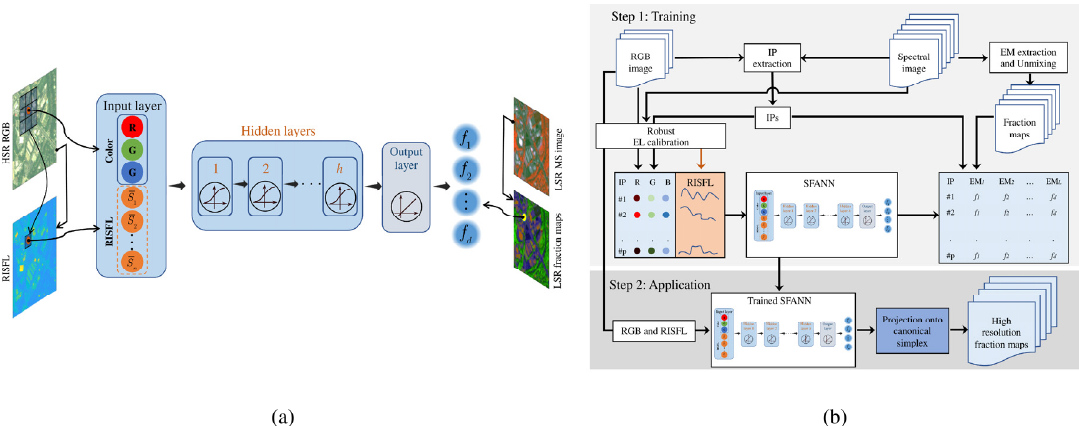
Figure 5. ( a ) Architecture of the spatial features-aided neural network (SFANN) designed for fraction estimation based on RGB values and RISFLs, with h hidden layers, ( b ) Conceptual framework of the proposed methodology.